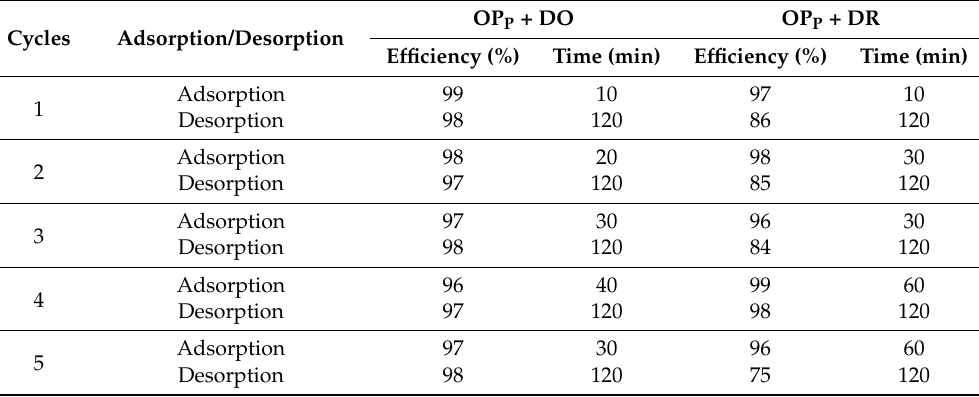
Table 3. Effect of DO and DR dye adsorption/desorption on the contact time evaluated considering the most efficient uptake or recovery of dye molecules from aqueous/acetic acid solutions